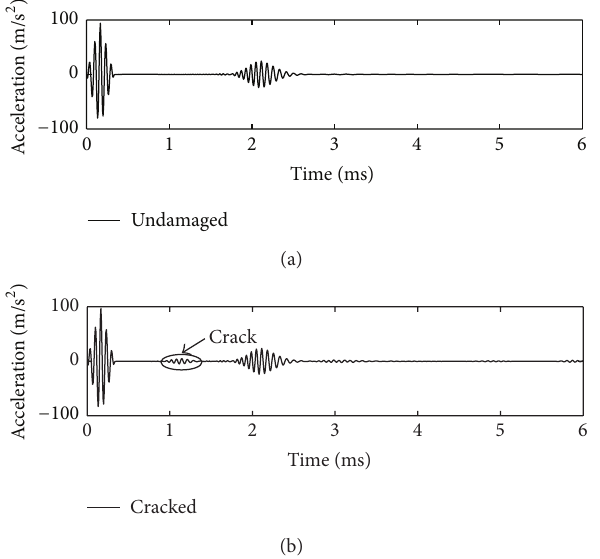
Figure 8: Acceleration response for undamaged (a) and damaged (b) beam.